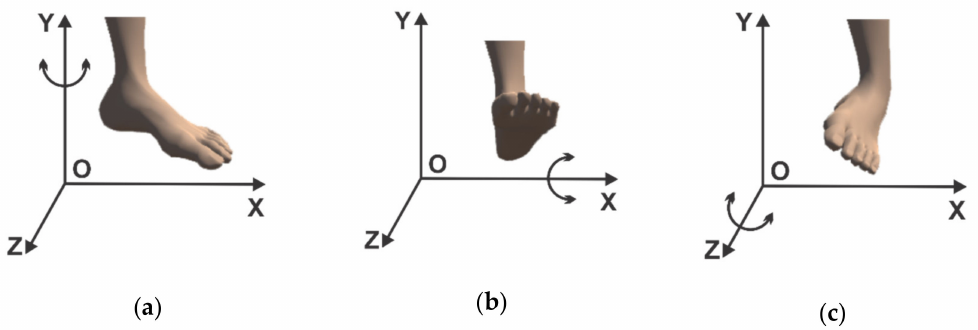
Figure 3. ( a) Ankle movement by rotation around the Oy axis. ( b ) Ankle movement by rotation around Ox axis. ( c ) Ankle movement by rotation around Oz